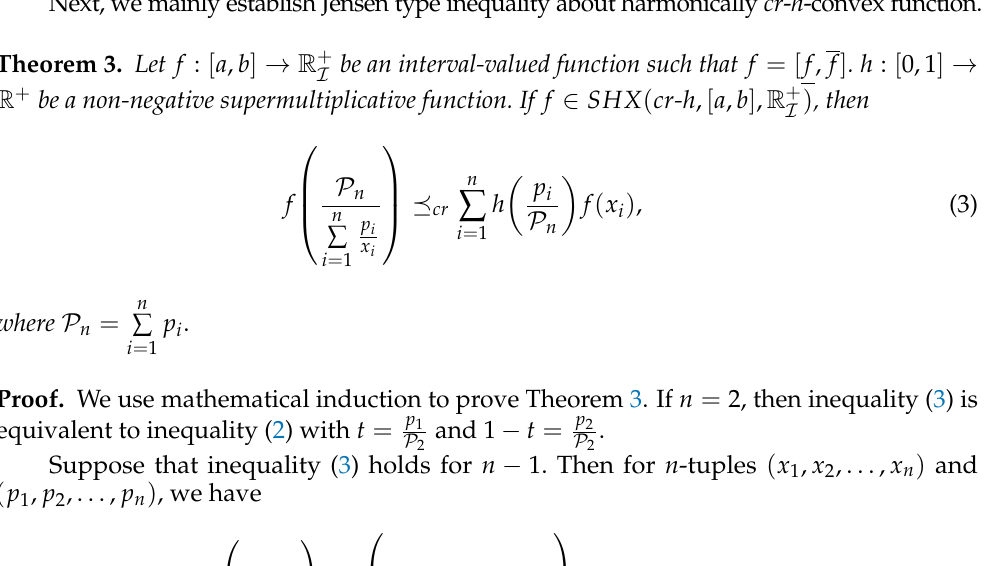
Figure 1. Illustrationof Example 1: The function f is a blue line and the function f is a red line. Next, we mainly establish Jensen type inequality about harmonically cr - h -convex